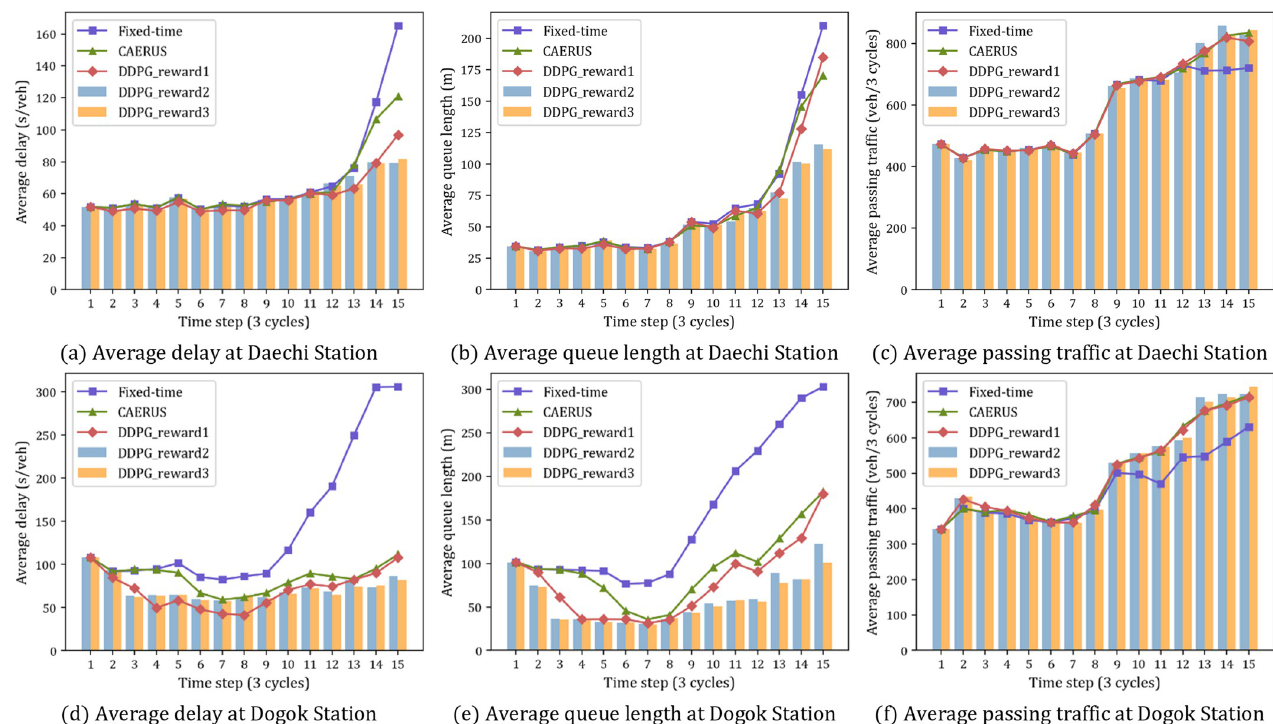
Fig 10. Comparing intersection results for different design scenarios. (a) Average delay at Daechi Station. (b) Average queue length at Daechi Station. (c) Average passing traffic at Daechi Station. (d) Average delay at Dogok Station. (e) Average queue length at Dogok Station. (f) Average passing traffic at Dogok